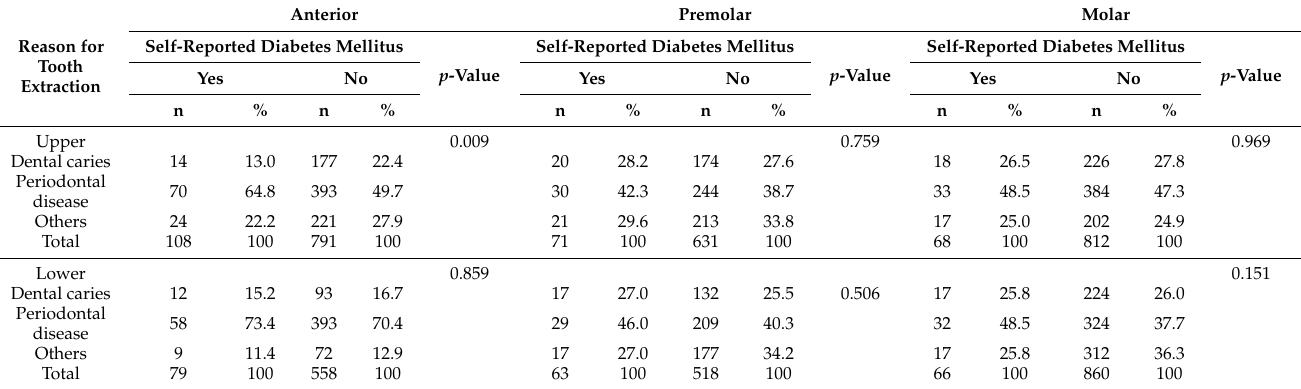
The reasons for tooth extraction are summarized in Table 3. As for the upper anterior teeth, the prevalence of tooth extraction by periodontal disease was higher among patients with self-reported diabetes mellitus than among those without diabetes mellitus (64.8% vs. 49.7%). Meanwhile, as for dental caries, patients without self-reported diabetes mellitus had more tooth extractions due to dental caries than patients with self-reported diabetes mellitus (22.4% vs. 13.0%). Regardless of the type of teeth, periodontal disease was the main reason for tooth extraction. Table 3. Reasons for tooth extraction by self-reported diabetes mellitus status and tooth type.